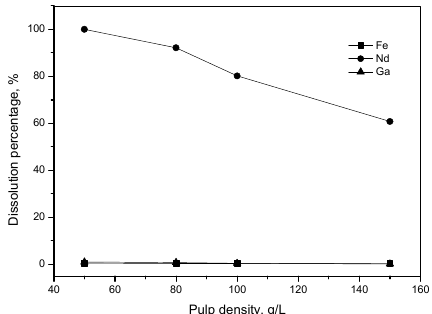
Figure 7. Effect of pulp density on the leaching of the oxide mixtures by 1.0 M HCl in EG. Operation conditions: T = 25 °C, time = 120 min, stirring speed = 400 rpm.